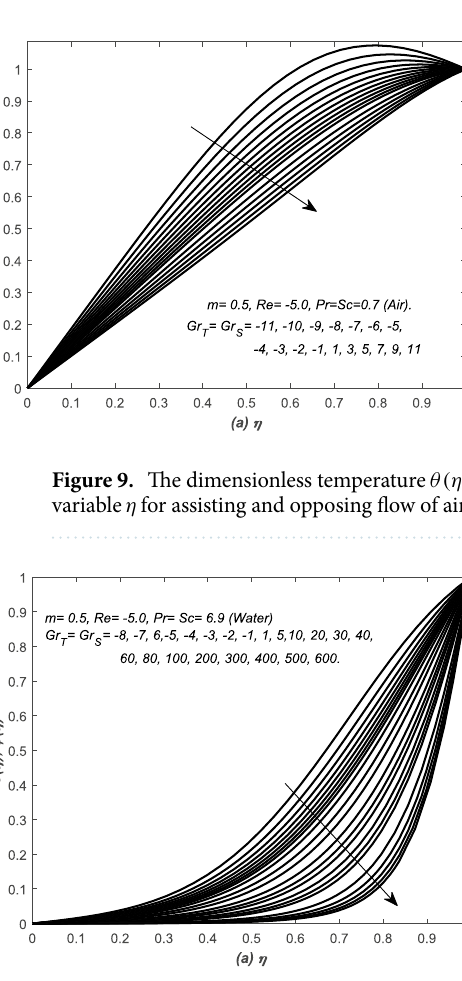
Figure 10. The dimensionless temperature θ(η) and species concentration φ(η) are plotted against the similarity variable η for assisting and opposing flow of water inside ( a ) converging and ( b ) diverging